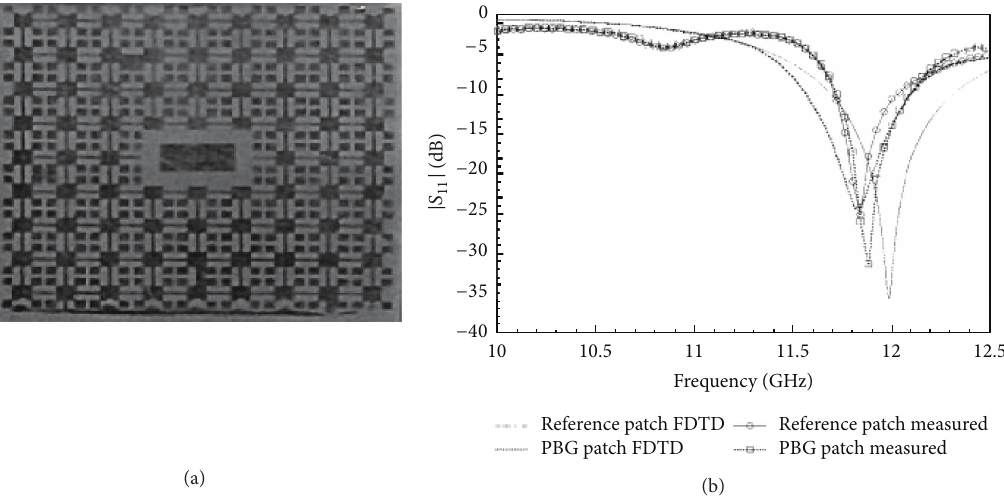
Figure 13: (a) An aperture coupled patch antenna surrounded by UC-EBG cells and (b) its return loss characteristics.